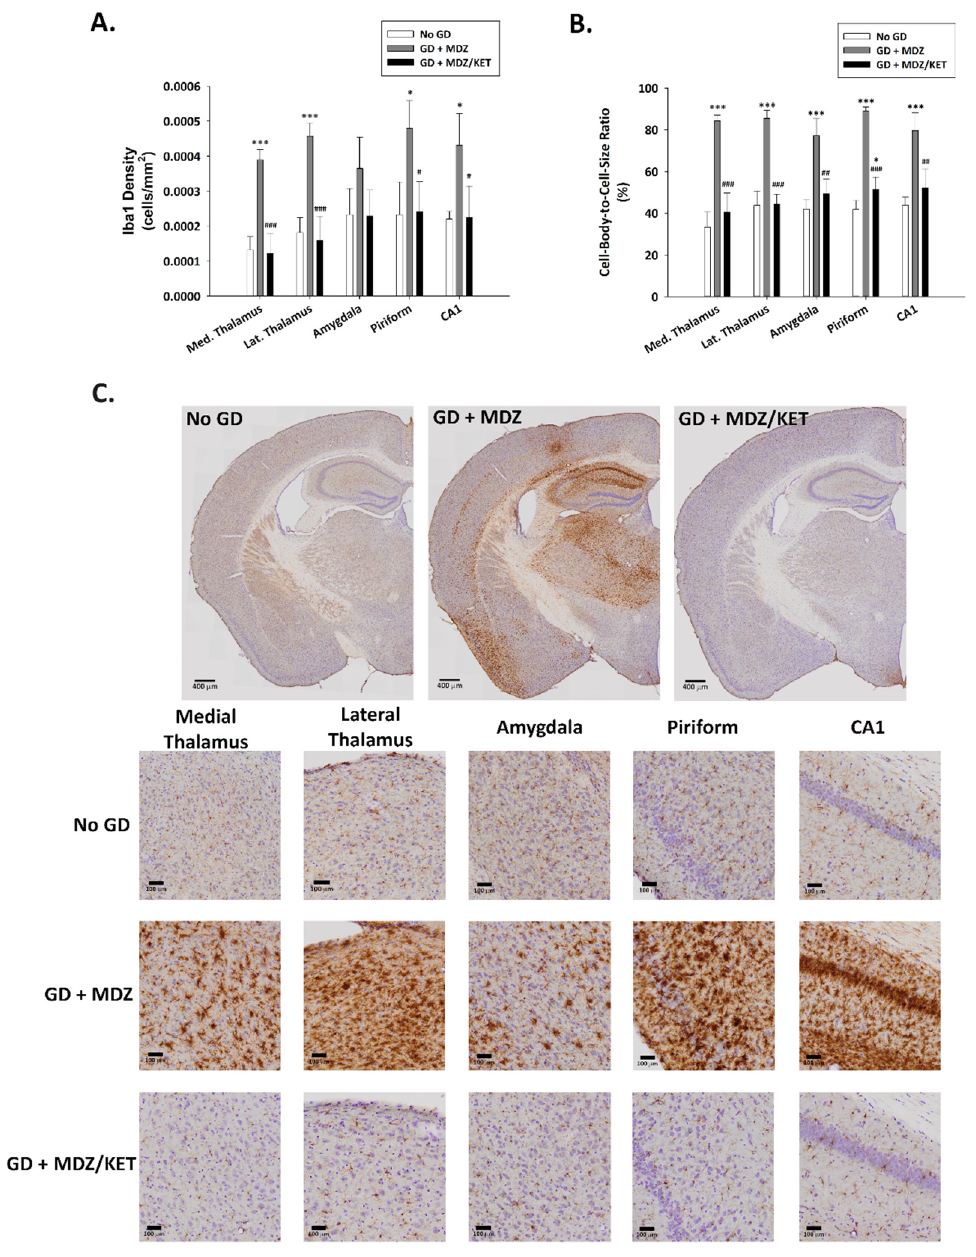
Figure 9. Effect of soman-induced status epilepticus and delayed midazolam monotherapy or midazolam/ketamine combination therapy on microgliosis and microglial cell activation in KIKO mice. At 2 weeks after SC soman-induced status epilepticus and delayed midazolam (GD + MDZ) or midazolam/ketamine (GD + MDZ/KET) therapy, KIKO mice were perfused, and brains collected for immunohistochemical processing with an antibody against Iba1 to visualize microglia. ( A ) Iba1-positive cells were counted and cell densities estimated in the medial thalamus, lateral thalamus, amygdala, piriform cortex, and CA1 region of the hippocampus from no agent controls (No GD; n = 4), GD + MDZ ( n = 3), and GD + MDZ/KET ( n = 5). ( B ) In the same brain regions, the cell-body-to-cell-size ratio, a measure of the conformational changes that occur following activation of microglia, was estimated. ( C ) Representative images, taken with a 0.75 NA 20X objective, are shown. * p < 0.05, *** p < 0.001, compared to No GD group; # p < 0.05, ## p < 0.01, ### p < 0.001, compared to GD + MDZ.